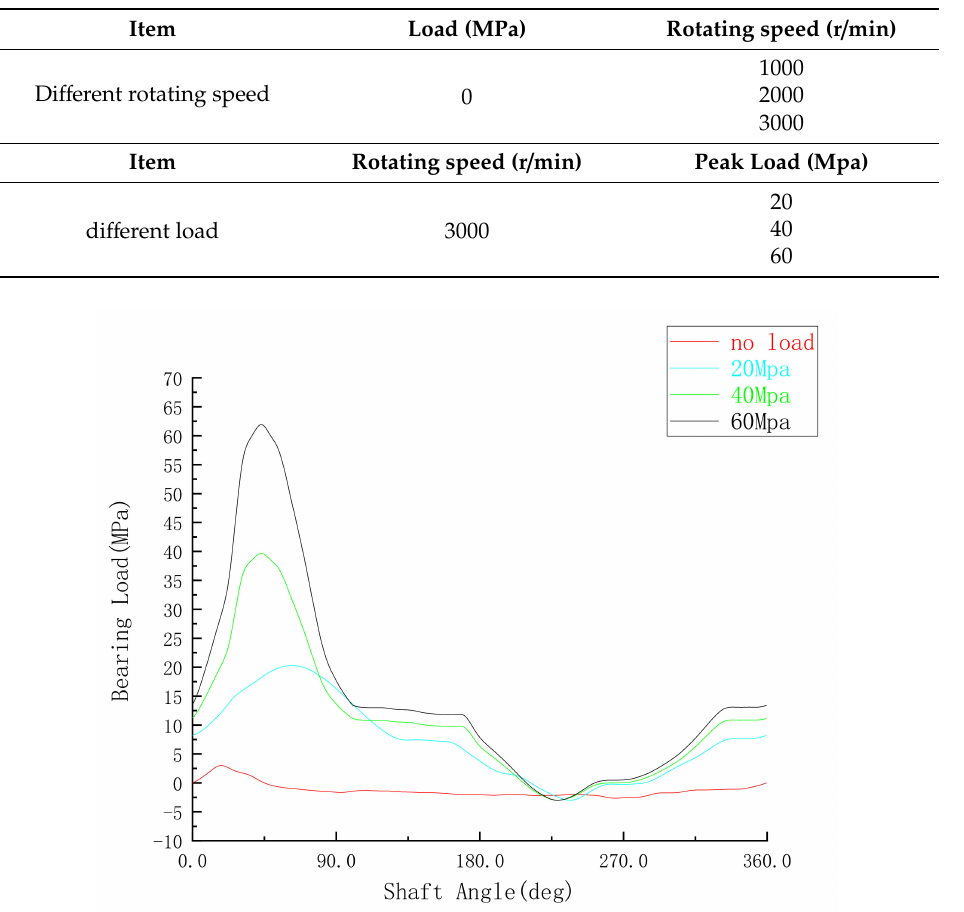
Table 1. Calculation and test scheme.